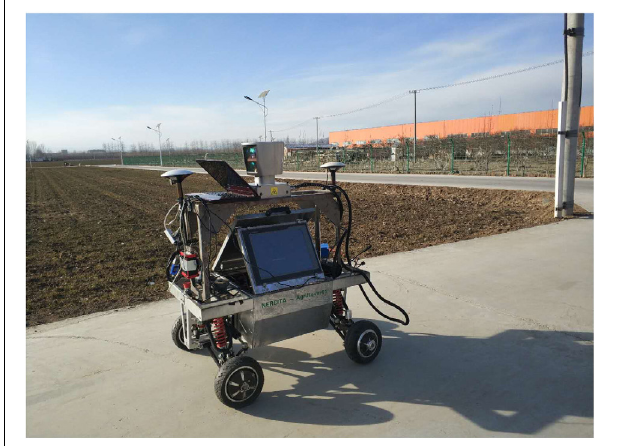
FIGURE 1 | Velodyne HDL64E-S3 on the